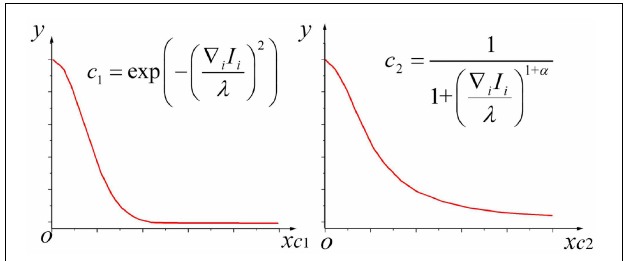
FIGURE 2 | Characteristic curves of diffusion coefficients c